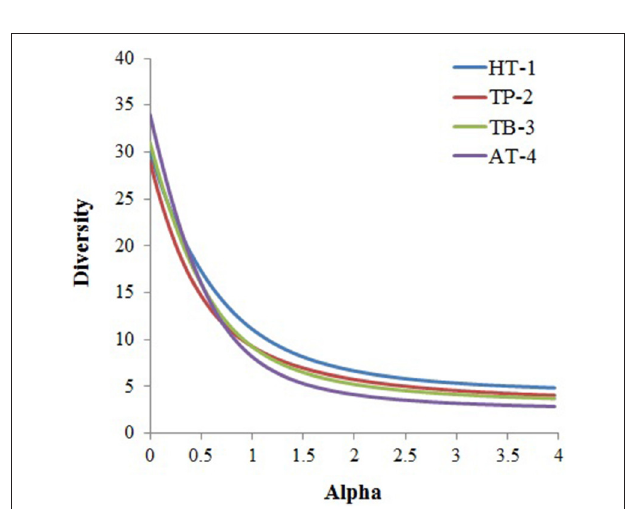
FIGURE 3 | Alpha diversity was calculated for each community based on taxa distribution at phylum level using the PAST statistical program. The phylum abundance for each metagenome was obtained from MEGAN5 taxonomic classification of the